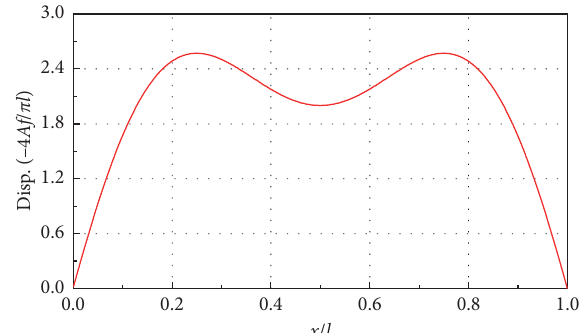
Figure 11: Deformation and displacement of the main cable microelement.